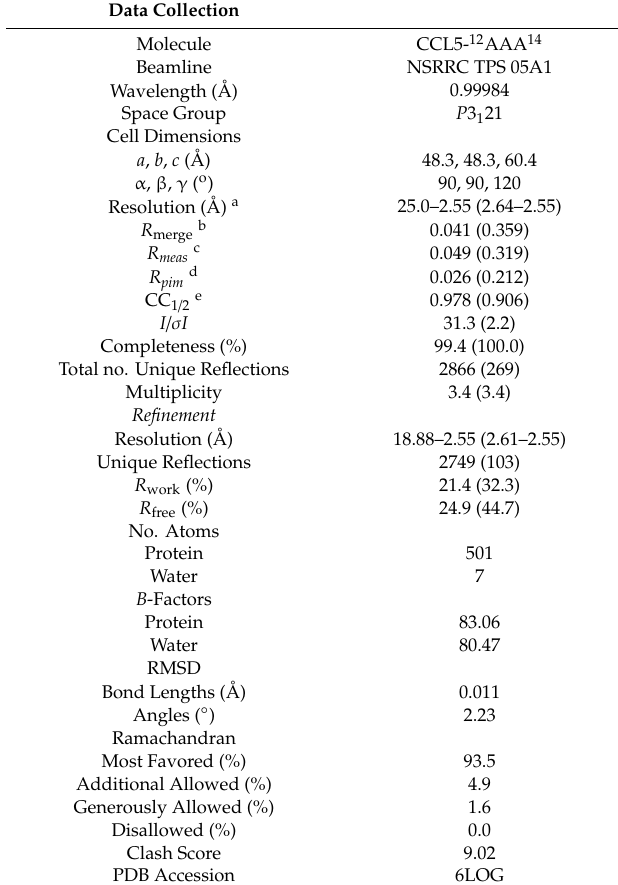
Table 1. Data collection and refinement statistics for the CCL5- 12 AAA 14